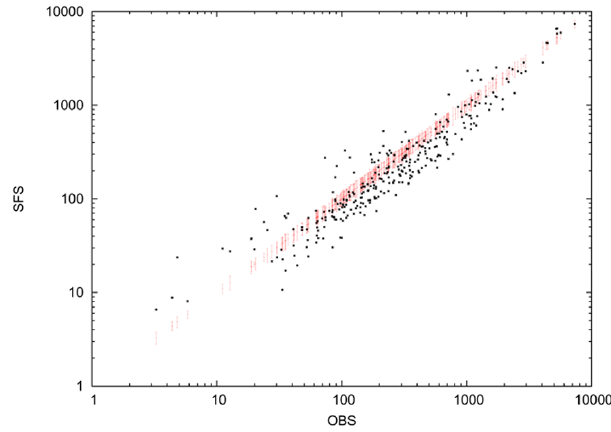
Fig. 1. Return level of SFS against observations OBS, for a ten-year return level on a log-log scale. The error bars correspond to the 95% confidence interval for the